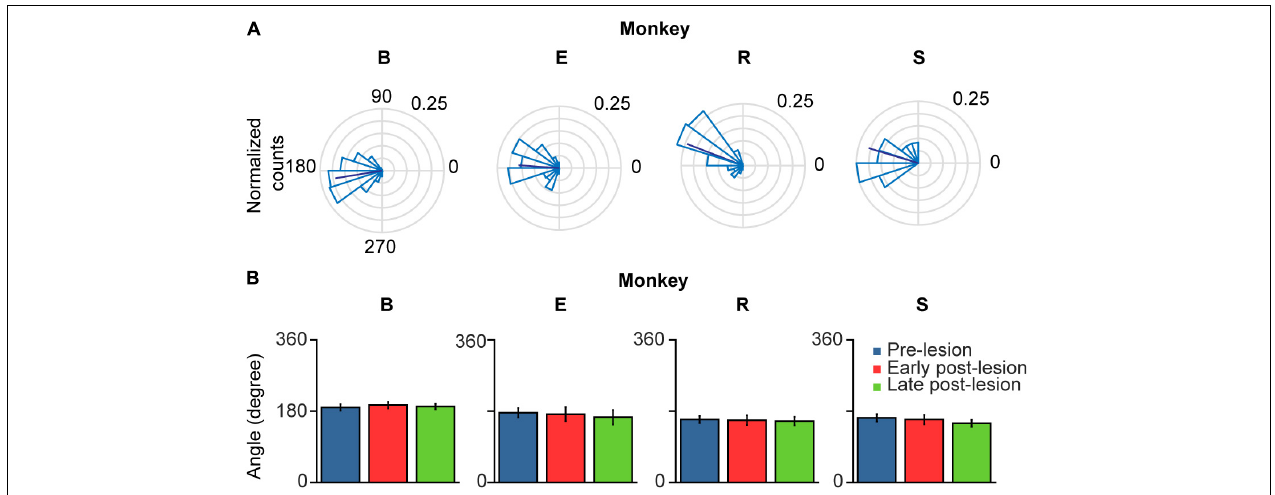
FIGURE 8 | Polar plots of glissade angle relative to saccade. (A) Normalized polar histograms of glissade direction relative to saccade direction (all saccade directions set to 0 ◦ , glissade direction relative to saccade direction is defined as θ saccade – θ glissade ) in the pre-lesion period. Dark blue line represents average vector of all glissade angles. (B) Mean glissade direction relative to saccade for pre-lesion and early and late post-lesion period. Only overshooting glissades were used for this analysis. Error bars represent one standard deviation. P -values of individual tests are in Supplementary Table 6 . Labels “B,” “E,” “R,” and “S” denote each of the four